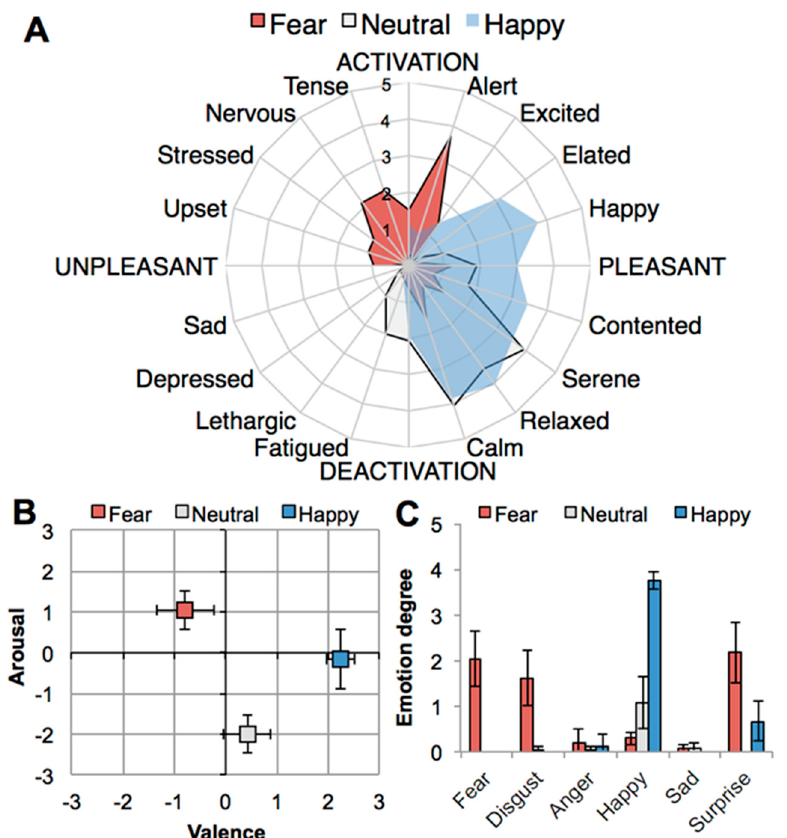
Figure 1. Effects of emotion induction (fear, neutral, happy) on self-reported emotional state: ( A ) Spider plot showing participants’ emotion profiles on affective circumplex [46]; ( B ) experienced core affect (valence, arousal) on affect grid [47]; ( C ) experienced discrete emotions. Error bars: ± 1 standard error of the mean (SEM).